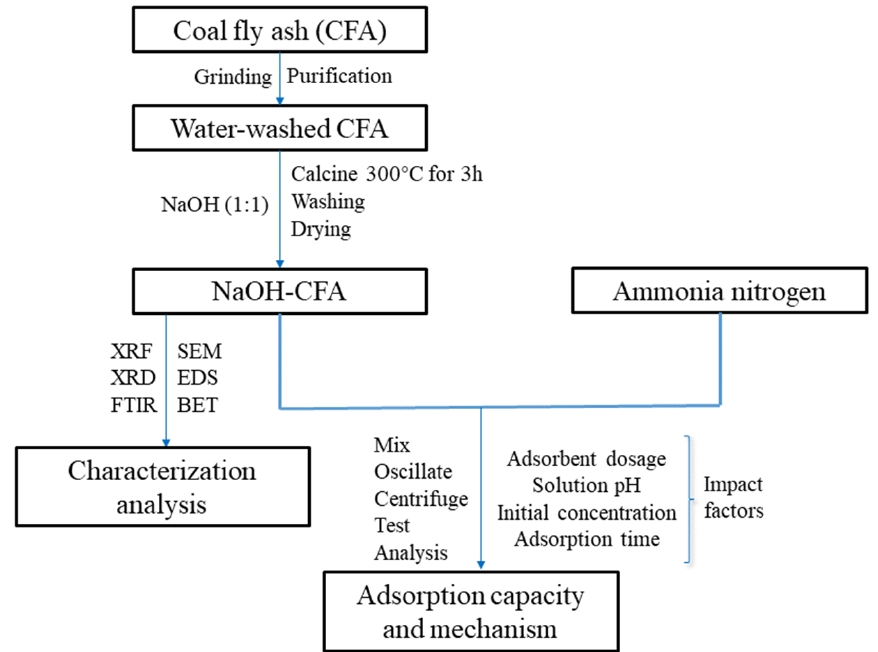
Figure 1. Scheme of NaOH ‐ CFA preparation, performance characterization, and adsorption analy ‐ sis.